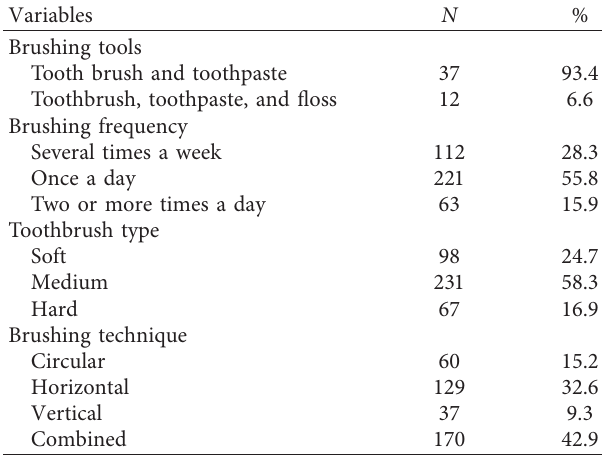
Table 3: Distribution of the sample size according to brushing habits: brushing tools, brushing frequency, toothbrush type, and brushing